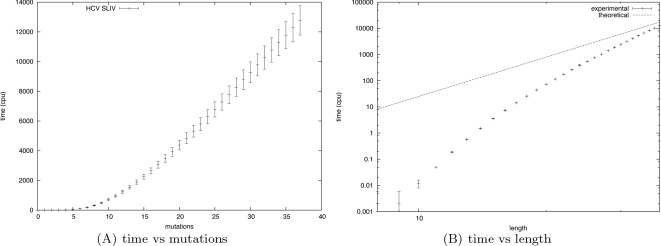
Time complexity measured for all Hepatitis C virus (HCV) stem-loop IV (SLIV) sequences from the Rfam seed alignment.(A) The x-axis represents the maximum number k of mutations, while the y-axis represents the time (in seconds) required by RNAmutants to compute the partition function Zi for each 0≤i≤k, and to sample 10 sequences and structures from the corresponding Boltzmann ensemble. Input length of HCV SLIV sequences is 37 nt. The average time over all 110 seed sequences of HCV SLIV is indicated by tick marks, while error bars represent ±1 standard deviation. (B) The x-axis represents the length of the input sequence, while the y-axis represents the time (in seconds) required by RNAmutants to compute the complete partition function Z for all mutants (i.e., all possible sequence of a given length). A logarithmic scale is used for both axis. For each length, the average time over five random sequences is indicated by tick marks, while error bars represent ±1 standard deviation. For comparison, a curve y = K·x
5 representing the theoretical bound of the time complexity is also plotted.